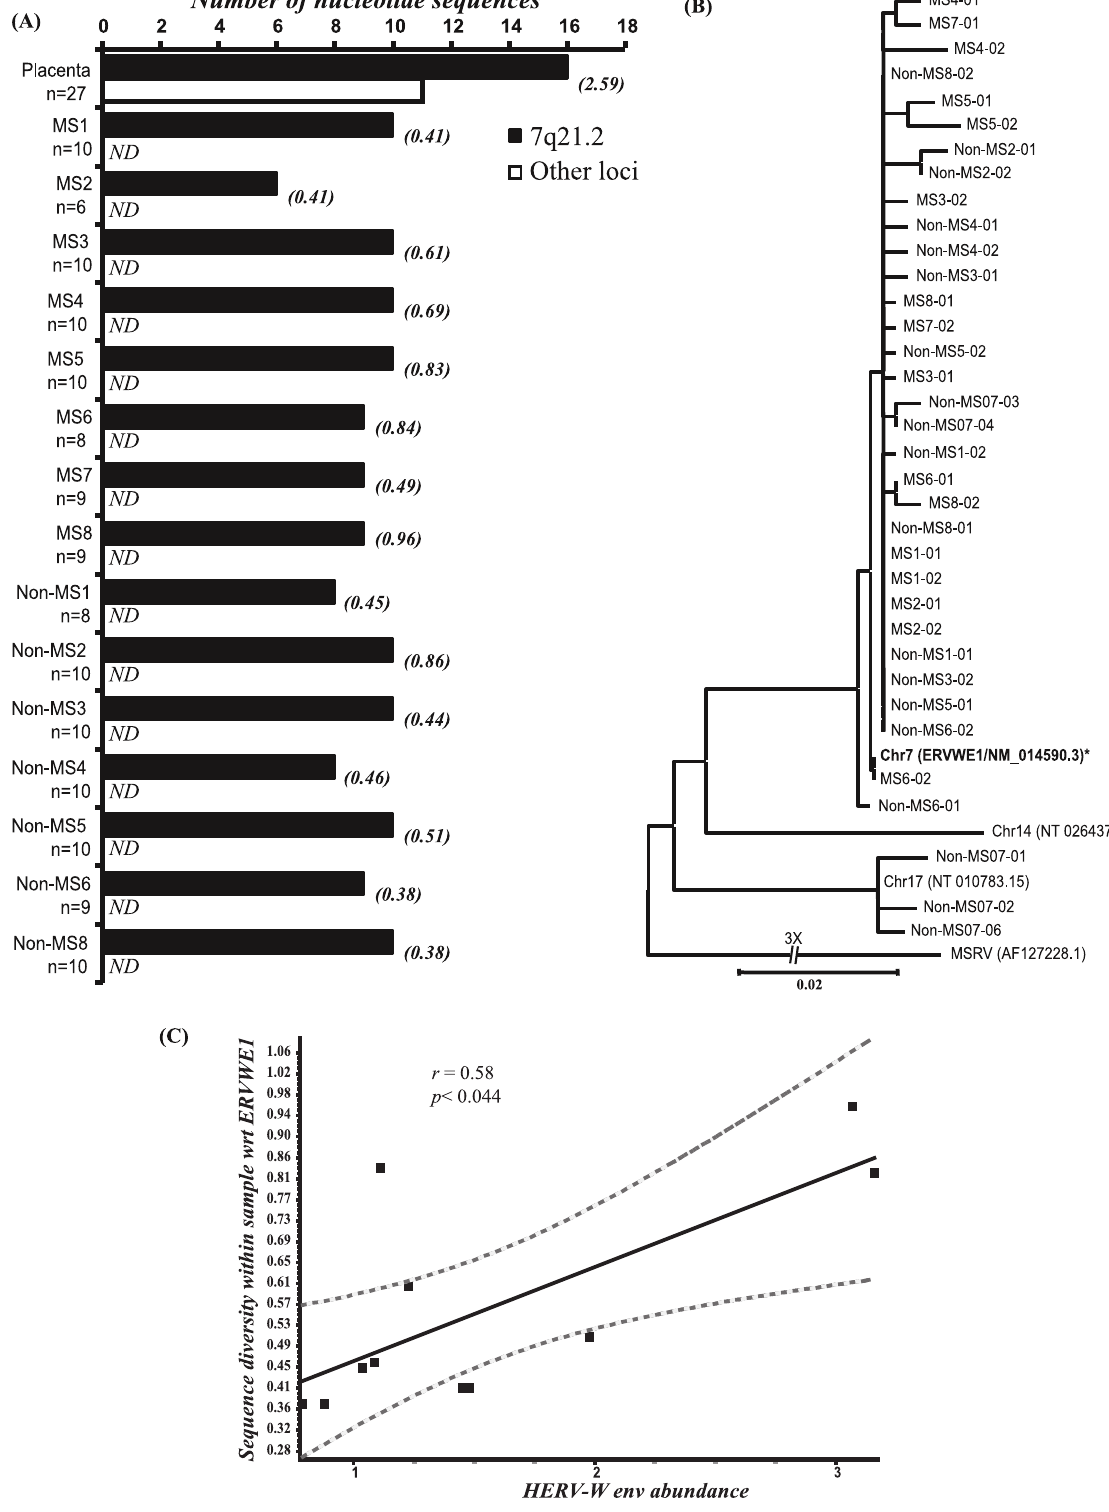
PLoS ONE | www.plosone.org 5 April 2011 | Volume 6 | Issue 4 |